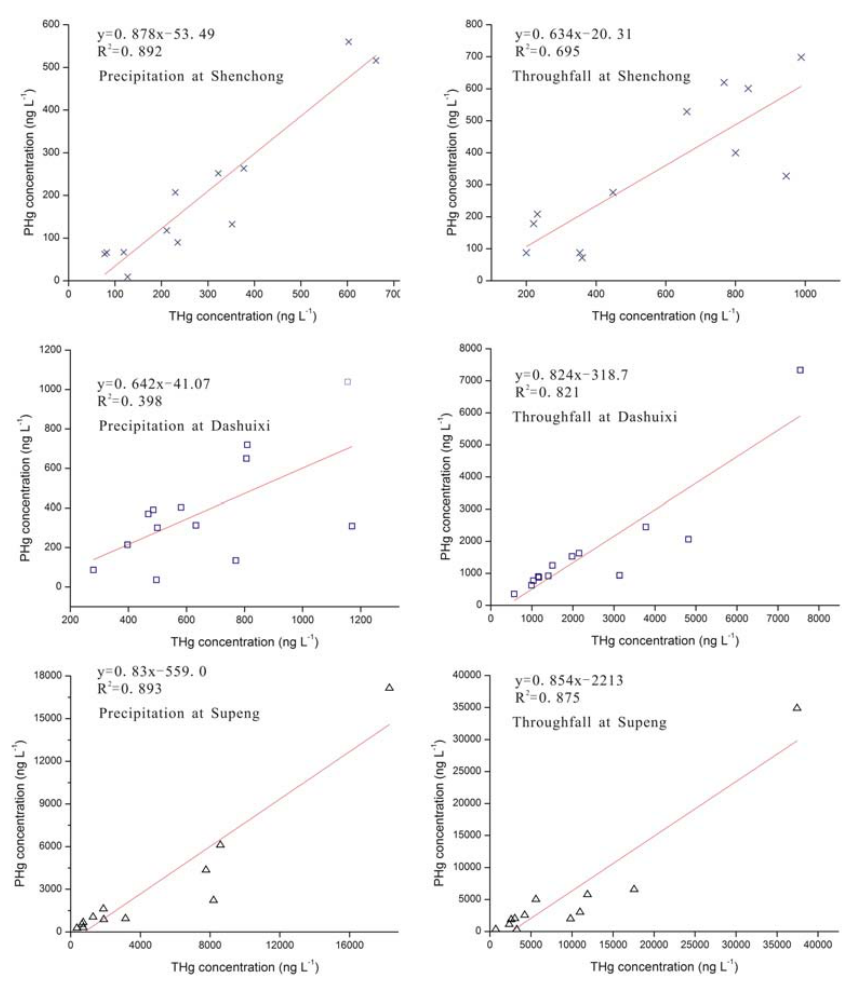
Fig. 4. Scatter plots of PHg vs. THg concentrations in precipitation and